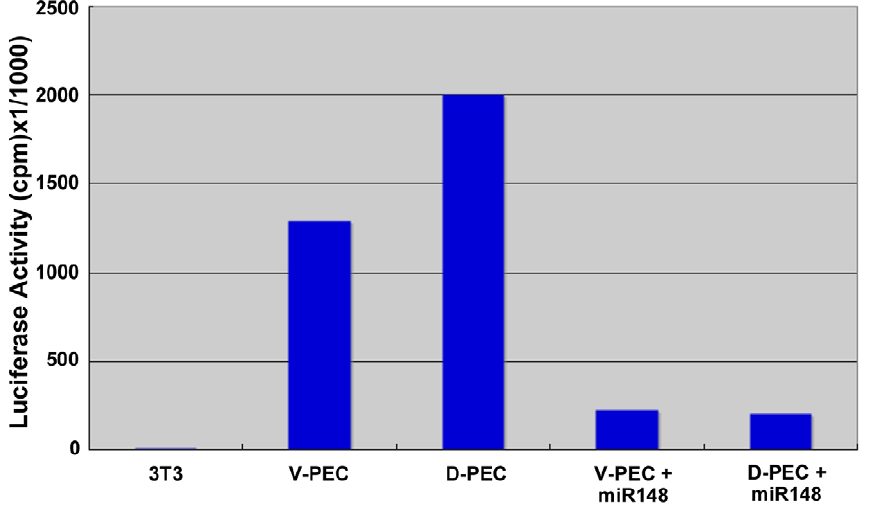
Figure 1. Luciferase activity. Luciferase activity in ventral and dorsal PECs transfected with a luciferase vector containing target target sequences for miR148. Note inhibition in cells that were co-transfected with miR-148. 3T3 cells were the untransfected control. The values are average of 20 measurements.